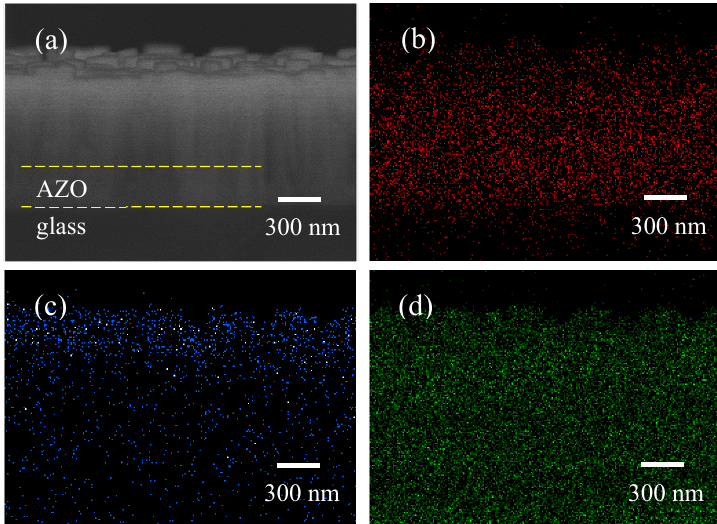
Figure 3. The energy dispersive X-ray spectroscopy (EDS) elemental mapping images of the ZnO nanorods coated with TiO 2 for 10 min (( a ) a field emission scanning electron microscope (FESEM) image; ( b ) a zinc element mapping image; ( c ) a titanium element mapping image; and ( d ) an oxygen element mapping image).